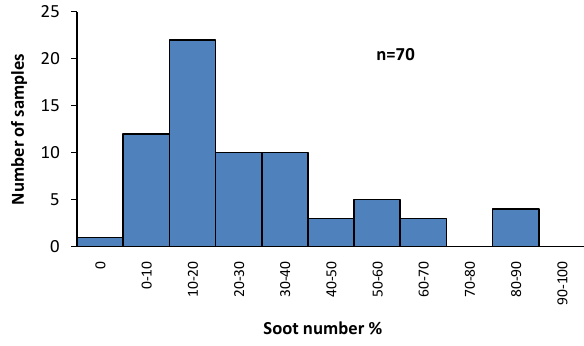
Fig. 5. The number of TEM samples with a percentage of soot par- ticles in the incremental range indicated on the x-axis. On average 27 ± 21% of the individual BB particles were identified as soot par- ticles (see Sect.